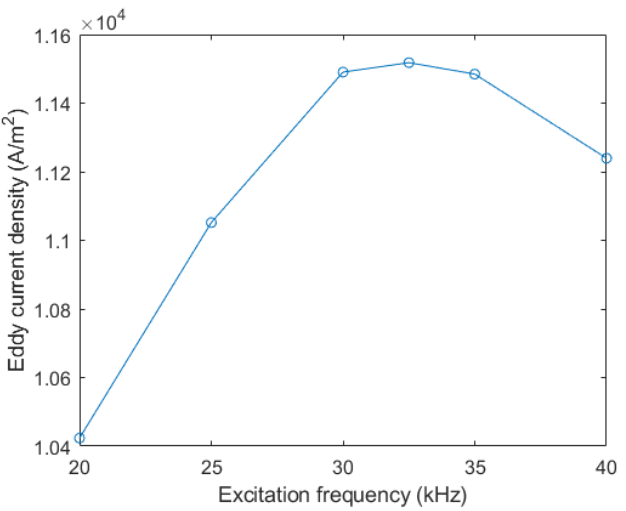
Figure 7. The eddy current density of point P under a different excitation frequency.